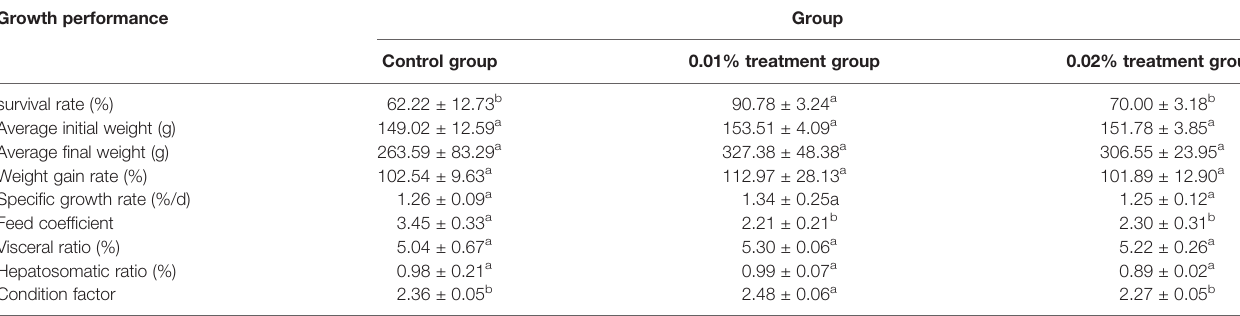
TABLE 3 | Effects of different levels of curcumin in feed on the growth performance of Seriola dumerili . Growth